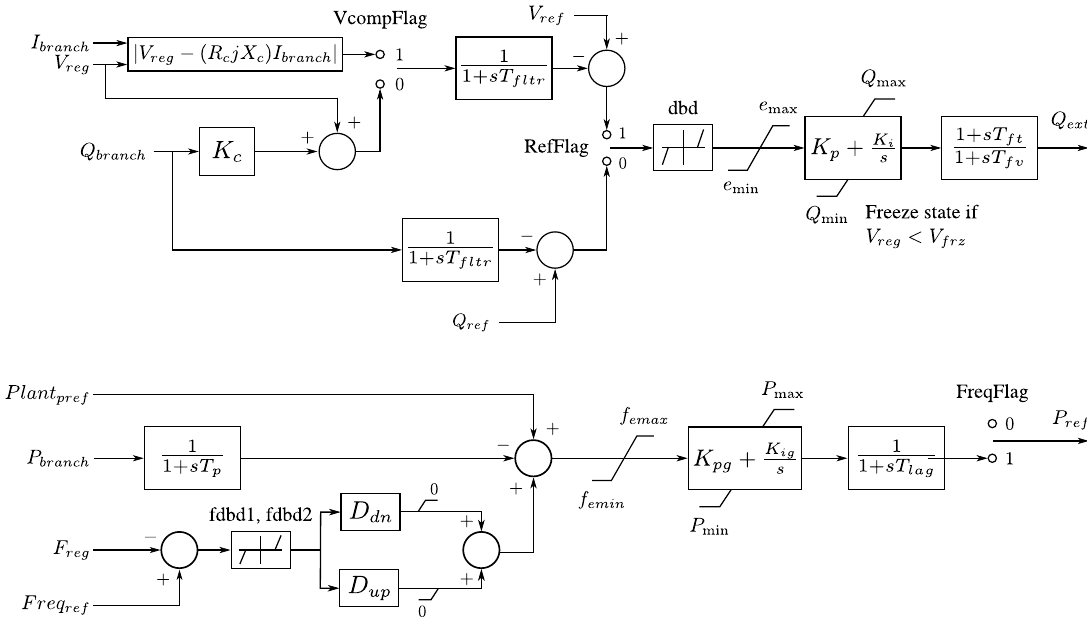
Figure 5. Second-generation PV model: plant controller